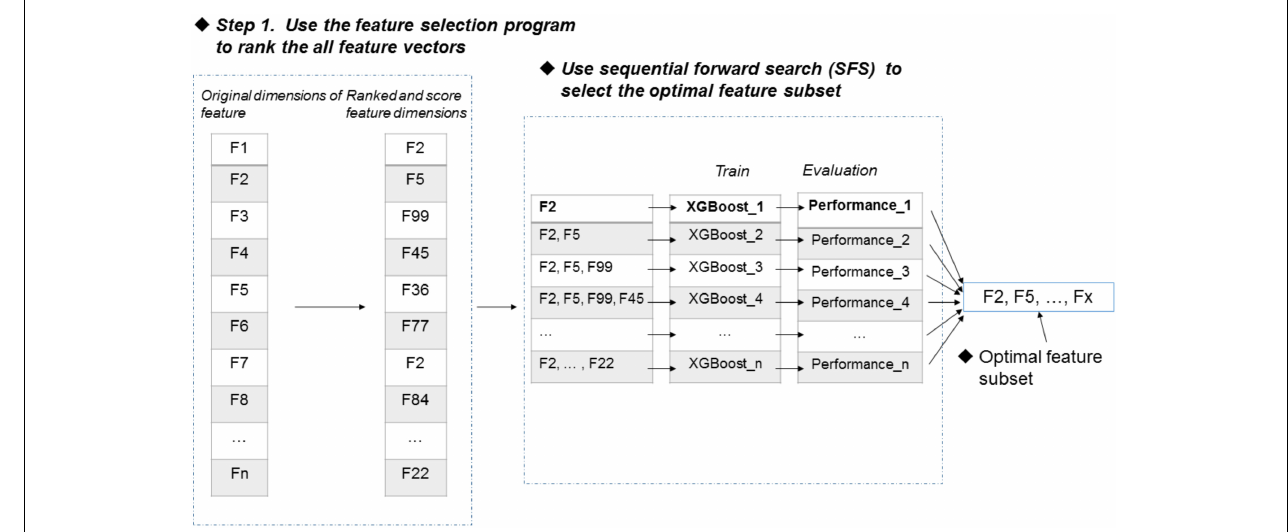
FIGURE 2 | Procedure of feature